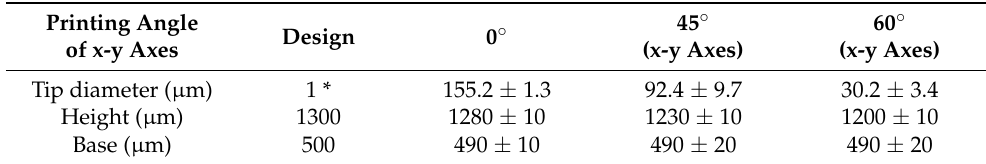
Figure 1. Effect of adjusting the 3D printing angle on the microneedle tip printing. Stereomicroscopic images of the microneedles at the different printing angles ( a ) 0 ◦ , ( b ) 45 ◦ , and ( c ) 60 ◦ to the x and y axes ( n = 7; the upper and lower scale bars are 0.3 mm and 0.5 mm, respectively). Table 2. Dimensions of the printed microneedles at different 3D printing angles 0 ◦ , 45 ◦ , and 60 ◦ to the x and y axes ( n =